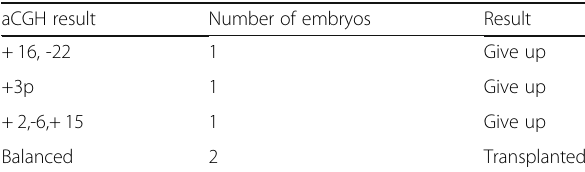
Table 1 Result of